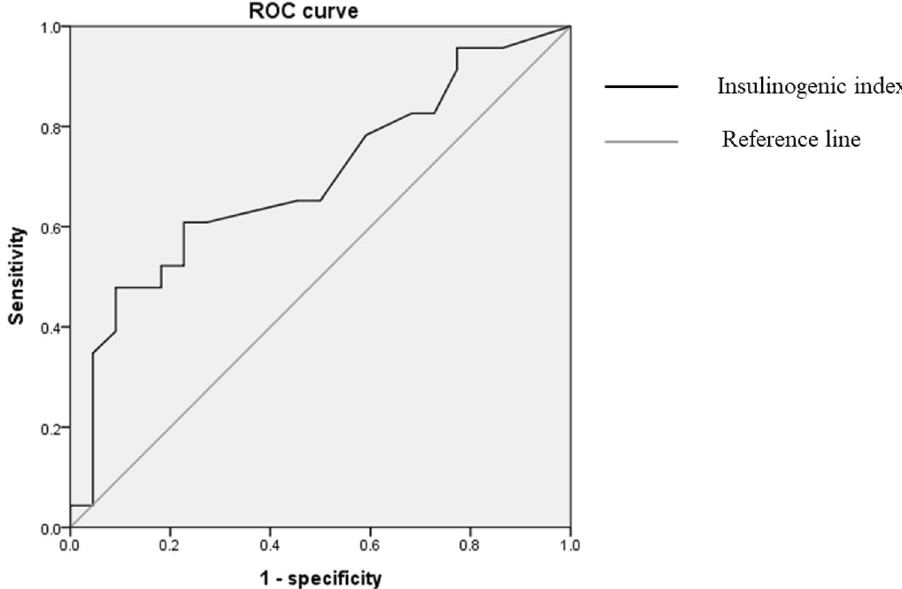
Figure 4. ROC curve of preoperative insulogenic